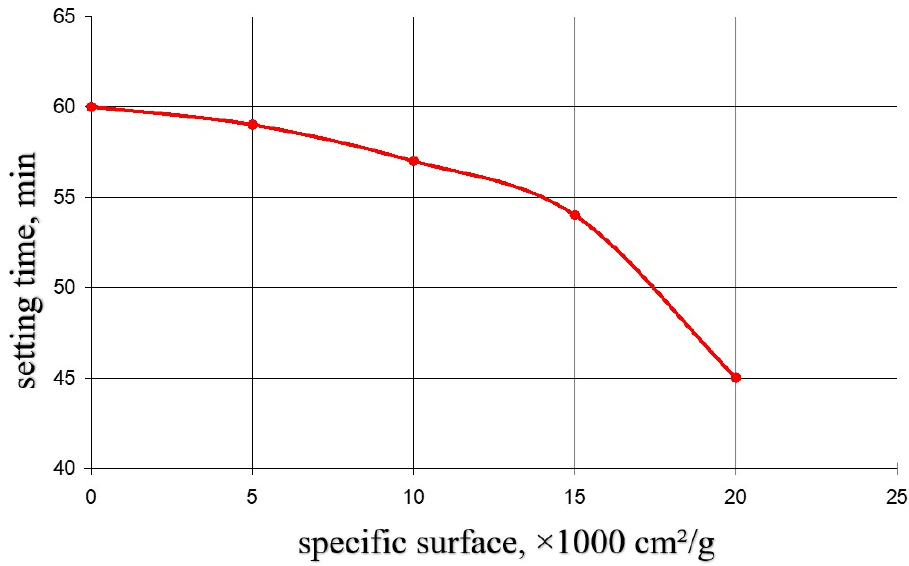
Figure 5. Dependence of the setting time on the dispersity of the anhydrite binder and lime mixture.